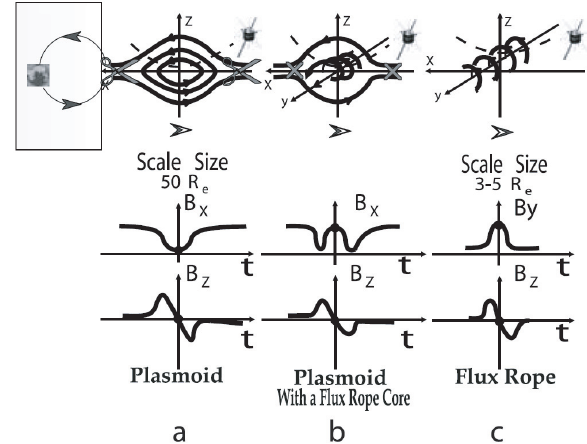
Fig. 3. Sketch of the magnetic configurations and signatures ex- pected for (a) closed-loop plasmoid structures; (b) high-field re- gions (plasmoids with flux rope core) and (c) flux ropes. The space- craft trajectory relative to the structure is shown as the dashed line in the upper panels, and leads to the signature shown below. The typical scale sizes in the distant tail are also indicated. (Adapted from Zong et al., 2004).